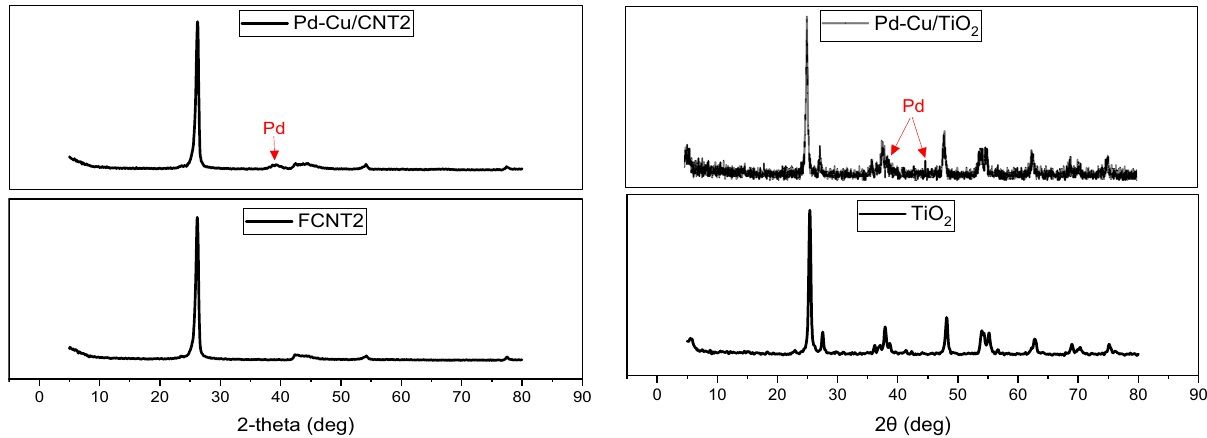
Figuree 4: XRD patterns of FCNT2 and 4Pd – 1Cu/FCNT2.